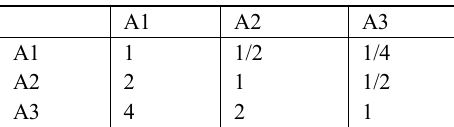
Table 2. Judgment matrix of the first criterion